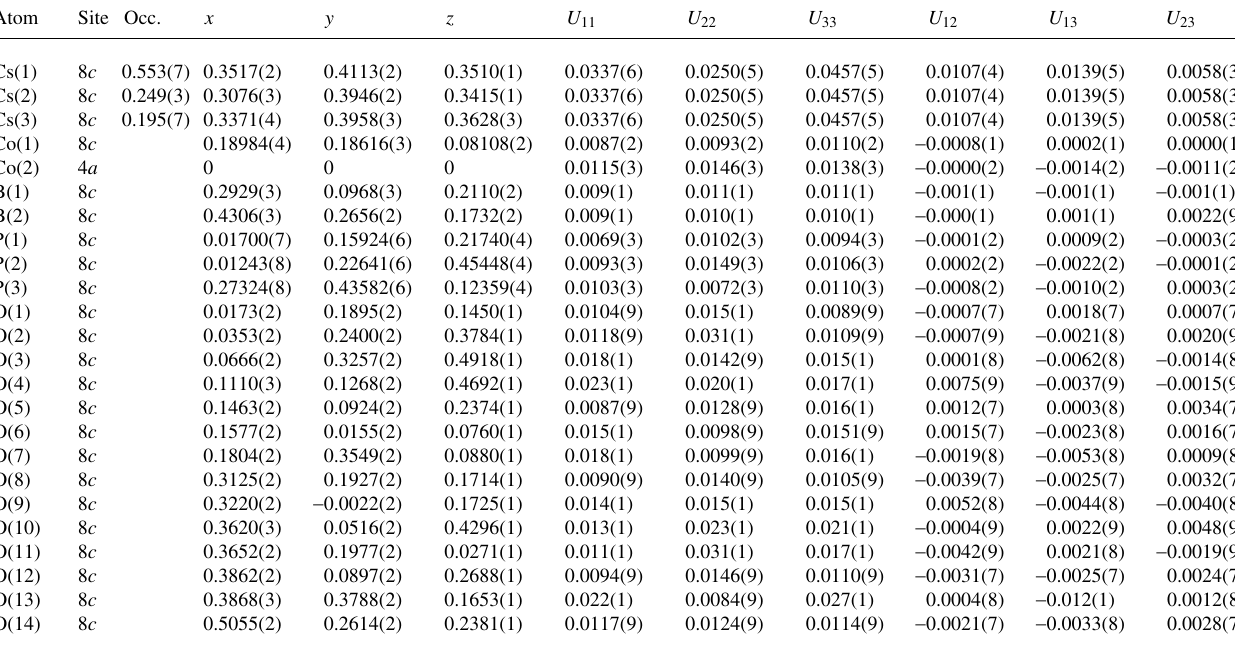
Table 3. Atomic coordinates and displacement parameters (in Å 2 ) .